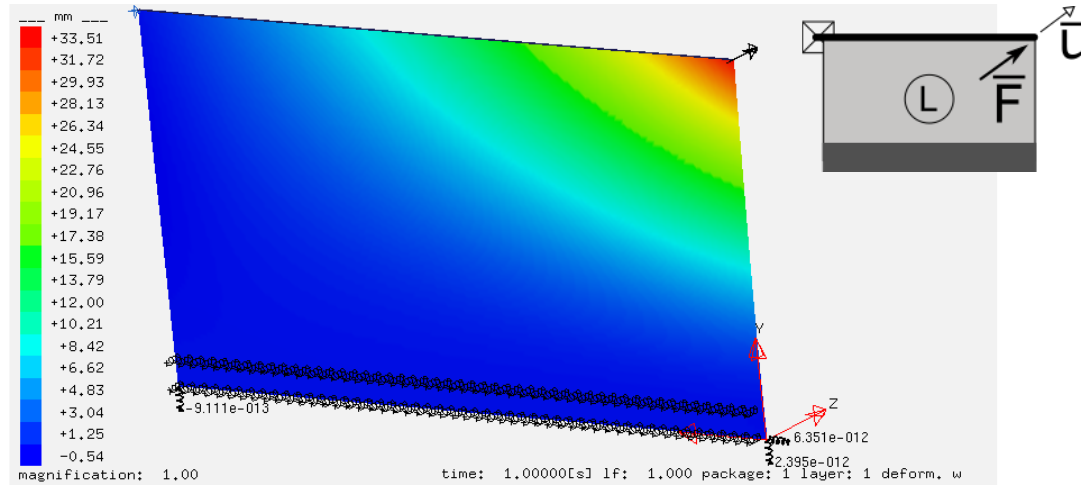
Fig. 6 Determination of the spring constant for both lateral elements simulated with SJ MEPLA® The springs are to be positioned at the cutaway ends of the handrail, which are synonymous with the upper right and upper left corner of the partially broken middle unit M. As also explained before, this leads to underestimated strains and therefore unsafe results. For that reason, this deficient practice is henceforth called the excessive approach.